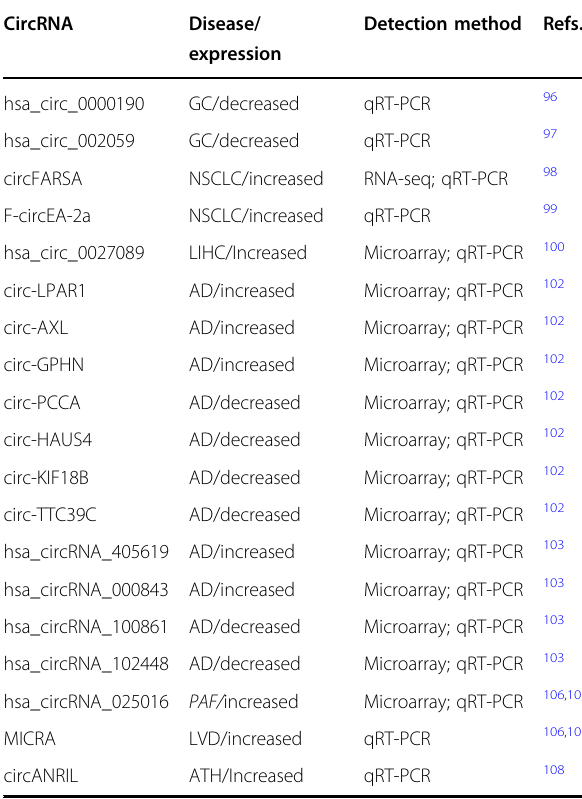
Table 1 CircRNAs as potential biomarkers of human diseases. CircRNA